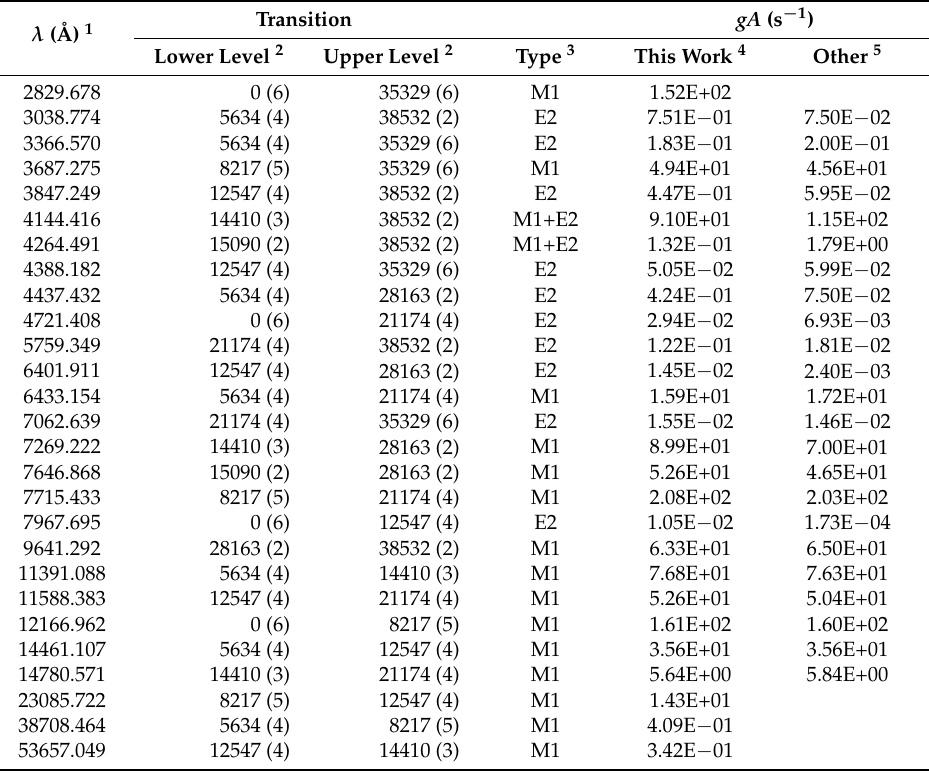
Table 3. Transition probabilities for forbidden lines within the 4f 12 ground-state configuration of Tm IV. Only transitions with gA -values greater than 0.01 s − 1 (according to our model A) are